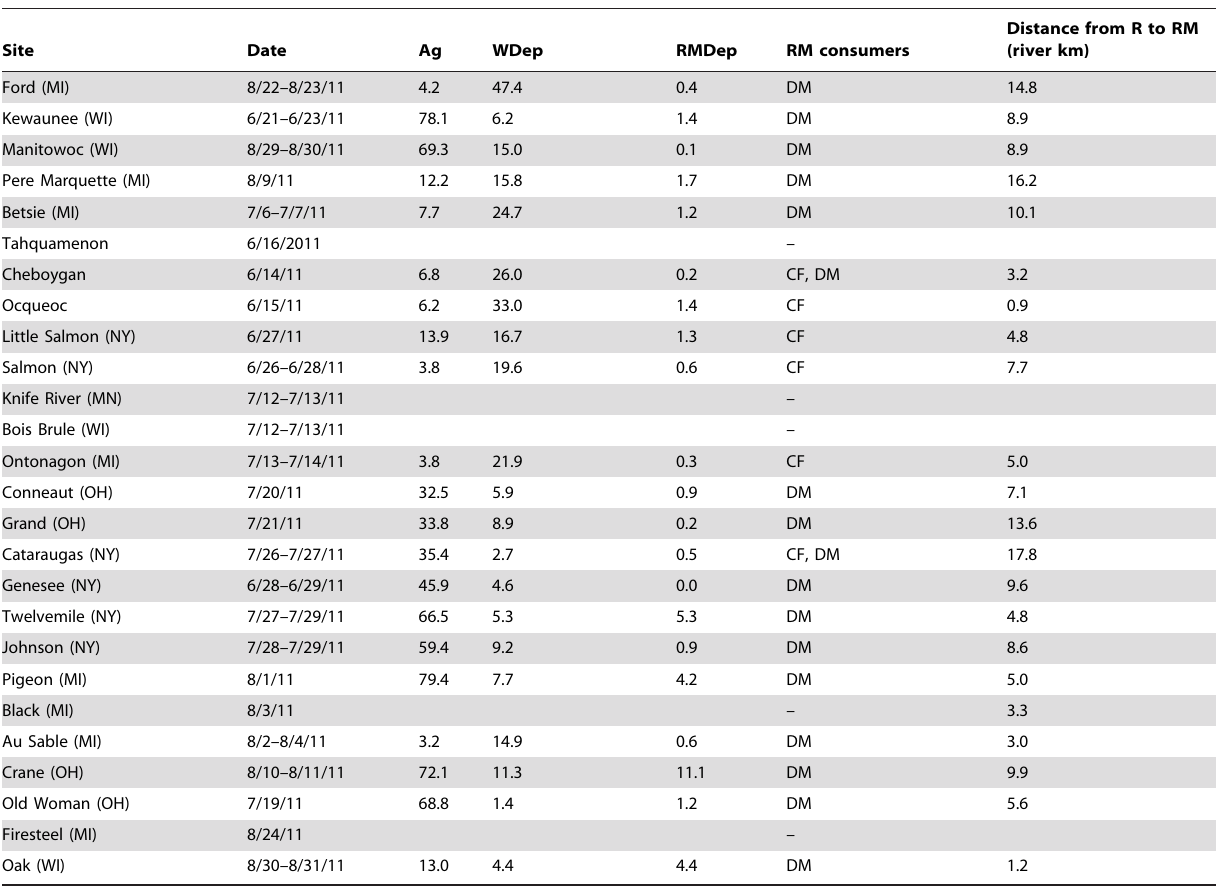
Table 1. Study sites and